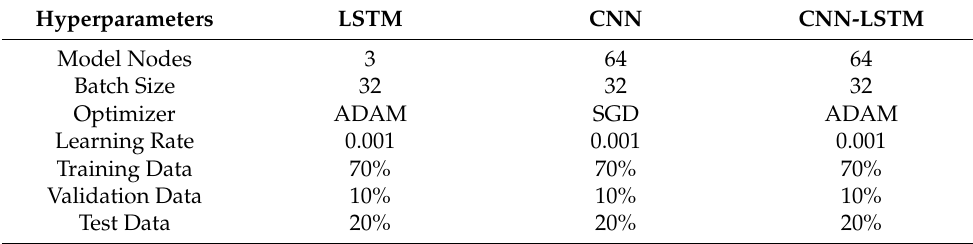
Table 5. Different parameter